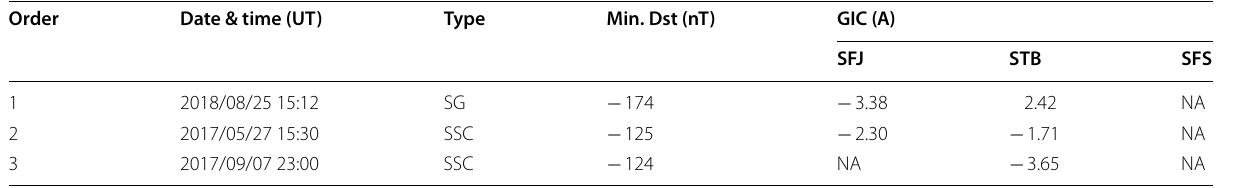
Table 3 Geomagnetic storms with real-time Dst index of less than -100 nT and maximum GICs associated with them between